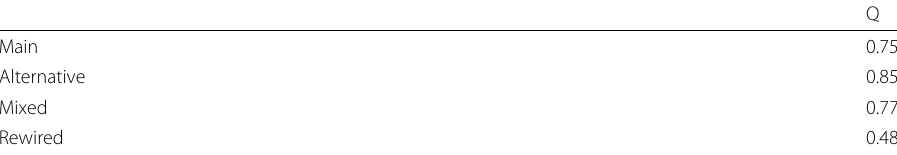
Table 4 Modularity of the Infomap